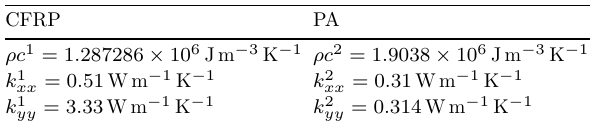
Table 1. Thermophysics parameters of the used materi-